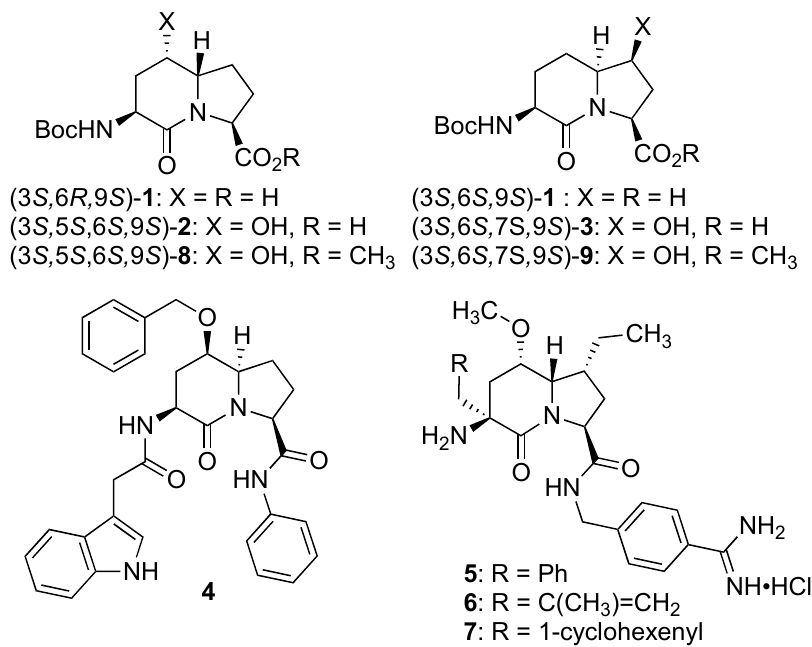
Figure 1. Indolizidine-2-one amino acid (Boc-I 2 aa-OH) isomers 1 , 5- and 7-hydroxy I 2 aas 2 and 3 , methyl ester counterparts 8 and 9, and biologically active 5- and 7-substituted I 2 aa NK-2 ligand 4 and thrombin inhibitors 5 – 7 .